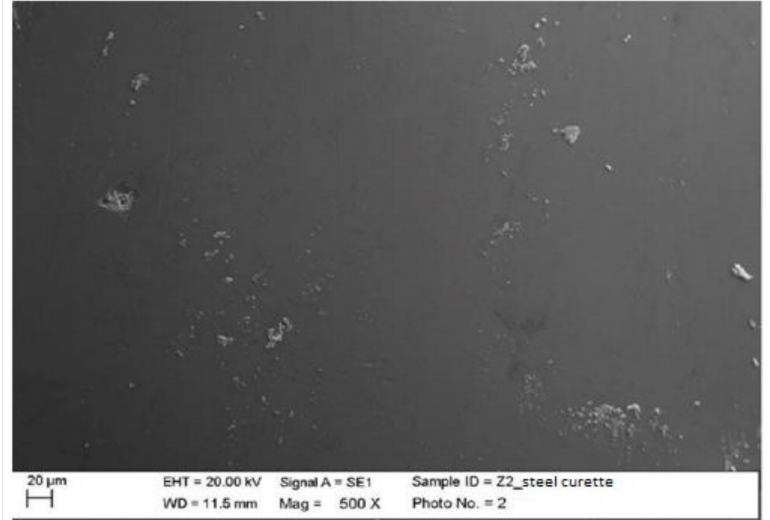
Figure 20. Instrumented zirconium sample Z2 with steel curette (500 ×